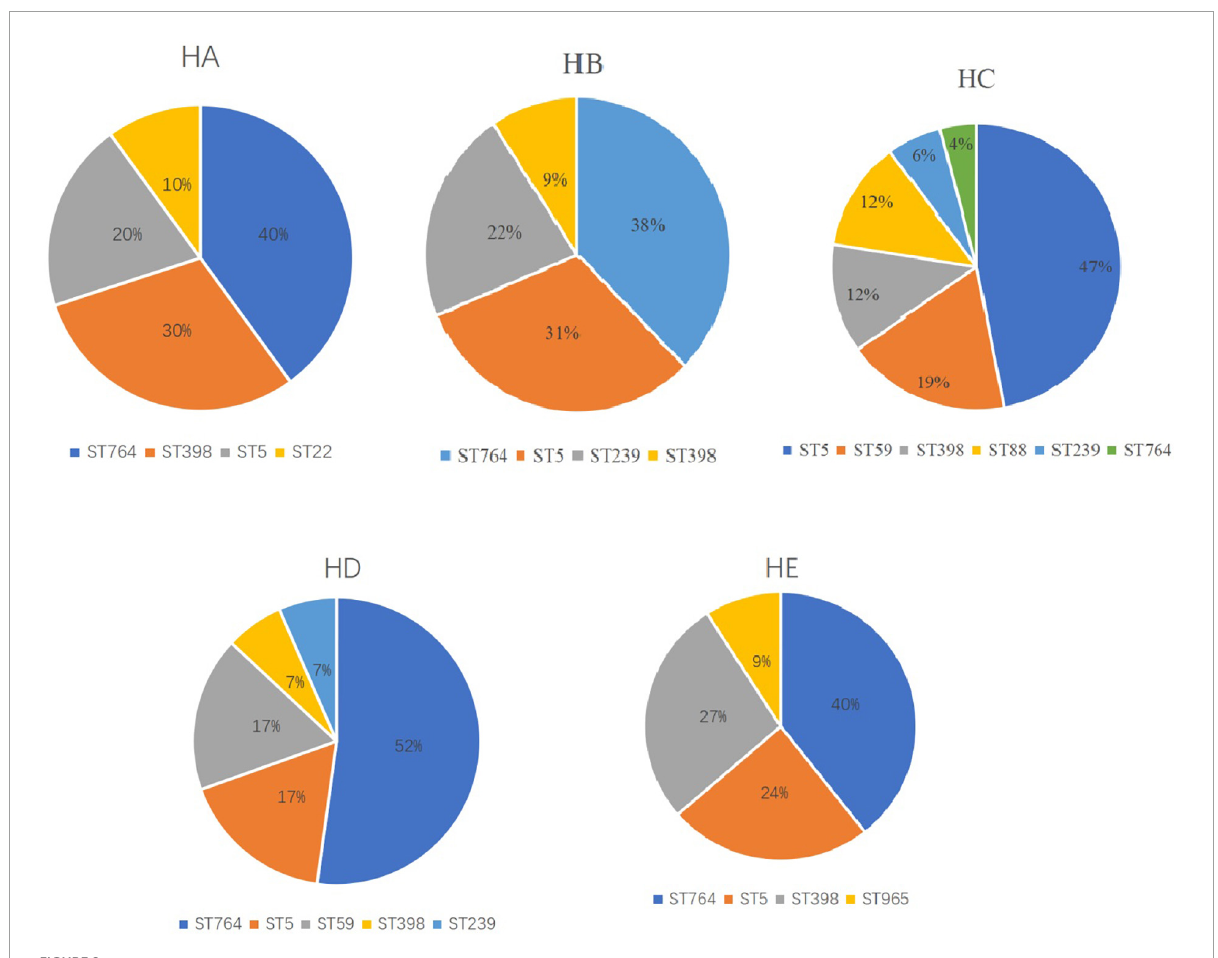
FIGURE2 Major sequence types (STs) in each of the five